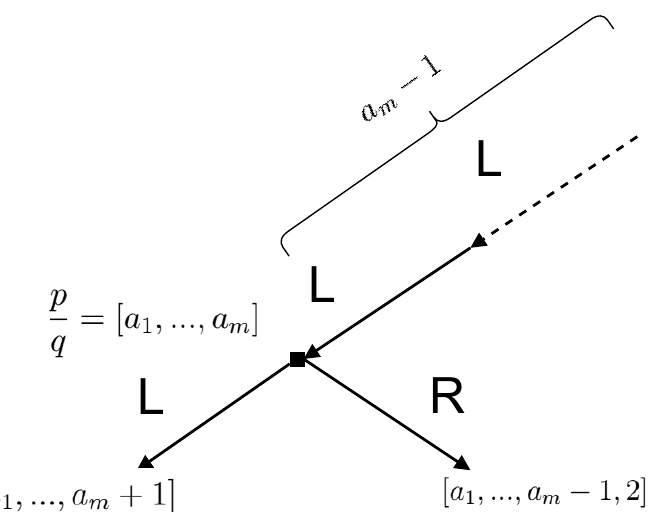
Figure A1. Diagram of the descendants of the Haros graph G p / q , with p / q = [ a 1 , . . . , a m ] . Let us suppose that the Haros graph G p / q contains a symbolic path that terminates in a m − 1 descents to the left L (the result is analogous for descents to right R ). The continued fraction for the left descendant of the Haros graph is [ a 1 , . . . , a m + 1 ] , whereas the right descendant has a continued fraction [ a 1 , . . . , a m − 1,2 ]